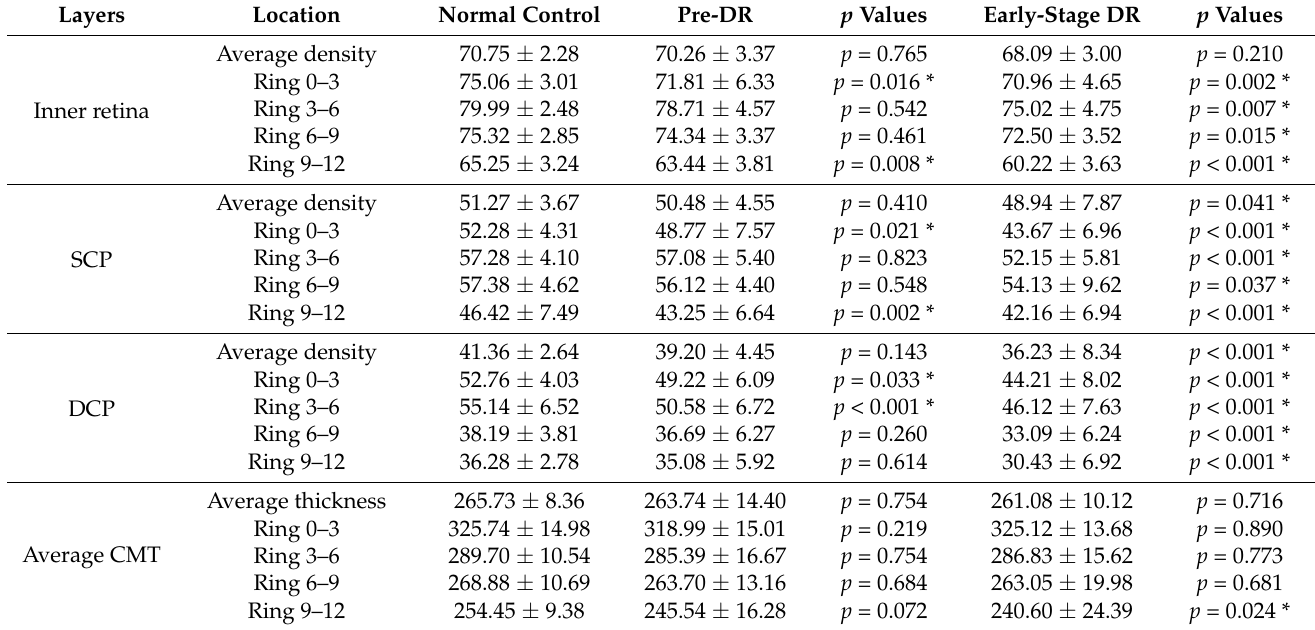
Table 2. Findings of optical coherence tomographical angiography in subjects with early-stage diabetic retinopathy, DM without ophthalmoscopic signs of DR and non-diabetic control